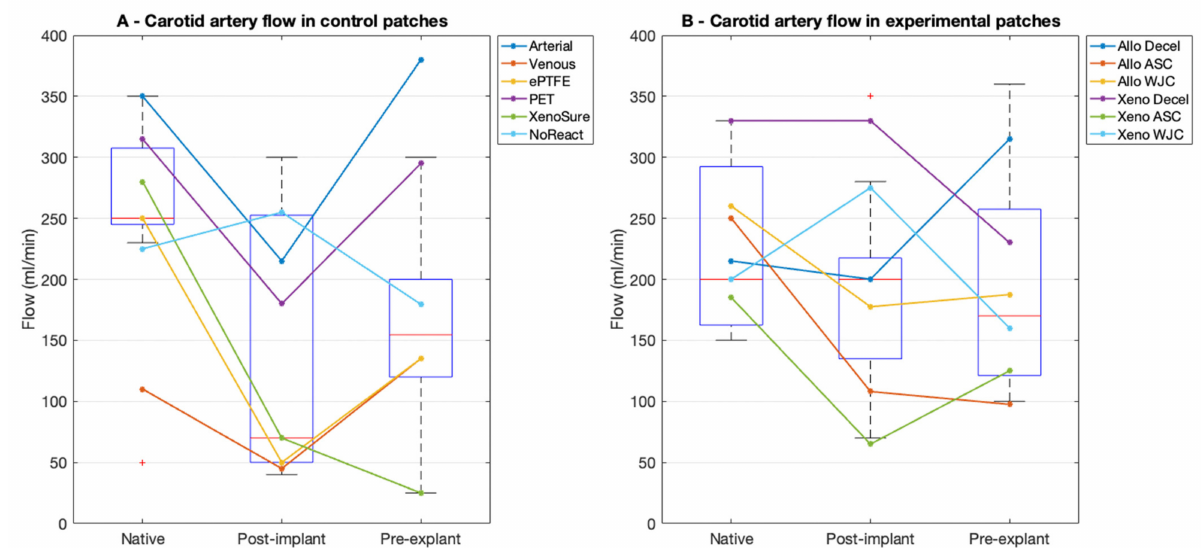
Figure 4. Flowmetry results in porcine carotid arteries. ( A ) We implanted six types of control vascular patches and ( B ) six types of experimental pericardial porcine allograft and ovine xenograft patches in a decellularized or recellularized form. Red lines represent median values, blue boxes 1st and 3rd quartiles, whiskers the minimum and maximum, and the red circles